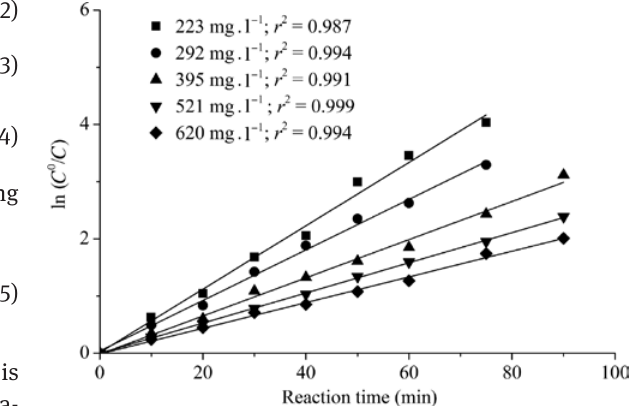
Figure 9: First-order kinetic study of the catalytic oxidation of DBT at different initial DBT